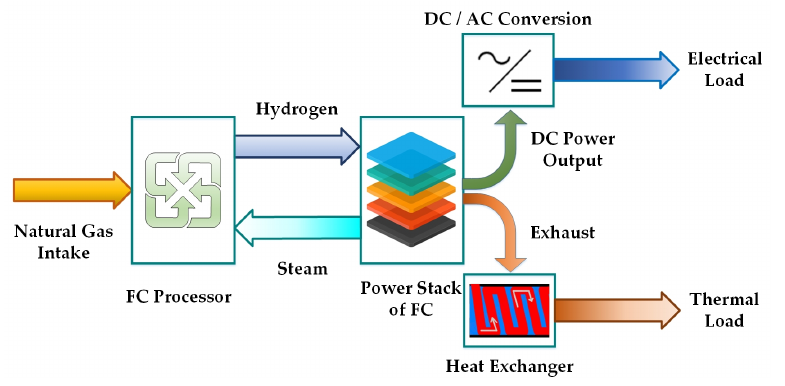
Figure 2. Fuel cell based CHP